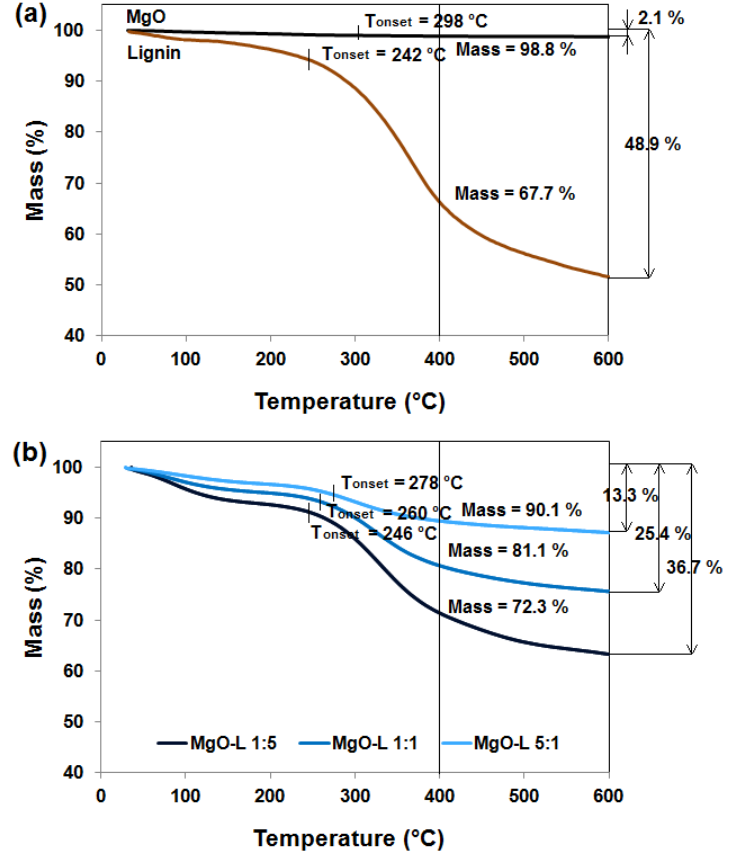
Figure 4. TGA curves of MgO and lignin ( a ) and MgO-lignin hybrid materials ( b ).